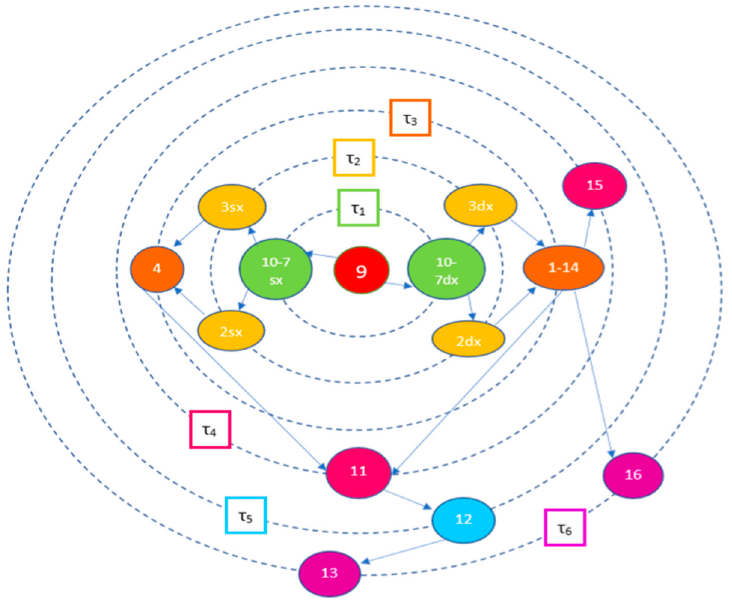
Figure 8. Removal order graph of the hydraulic external gear pump.